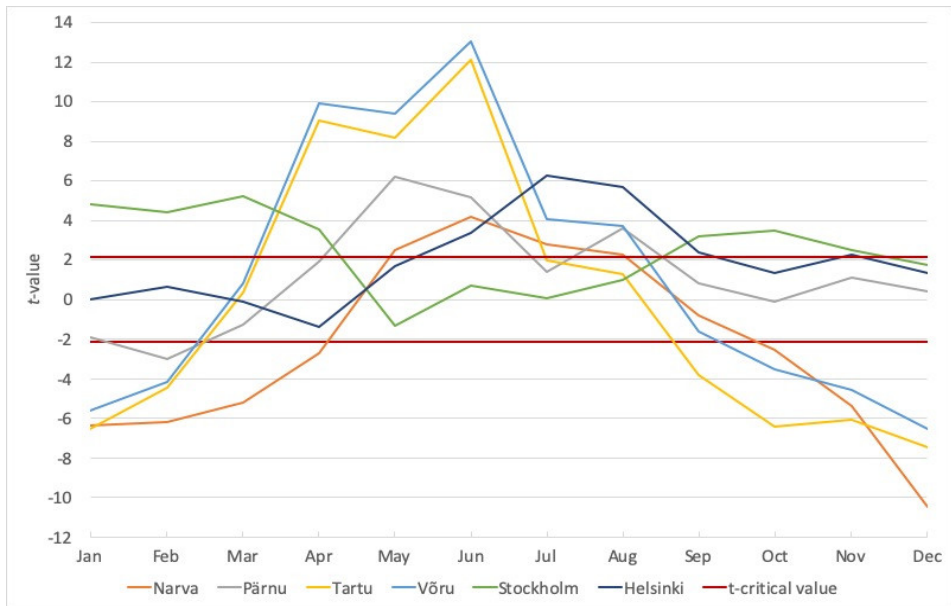
Figure 10. Testing the hypothesis (surface air temperatures in the different cities are equal to the surface air temperature in Tallinn in any given month) using Welch’s t -test. The hypothesis is valid if the value of the test statistic t is in the range of − t critical to t critical